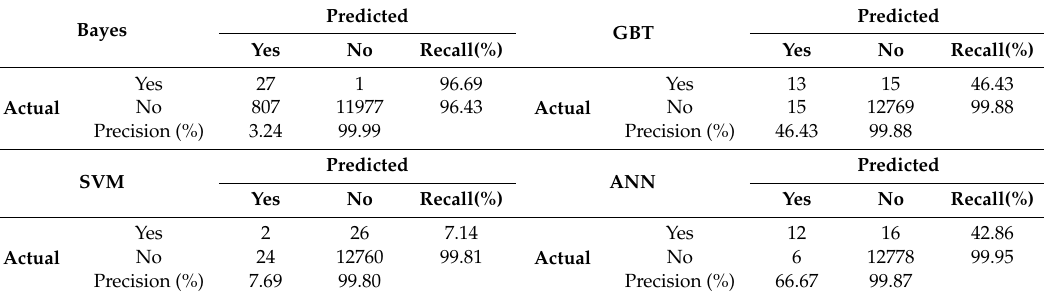
Table 8. Confusion matrices for the PVC pipes test